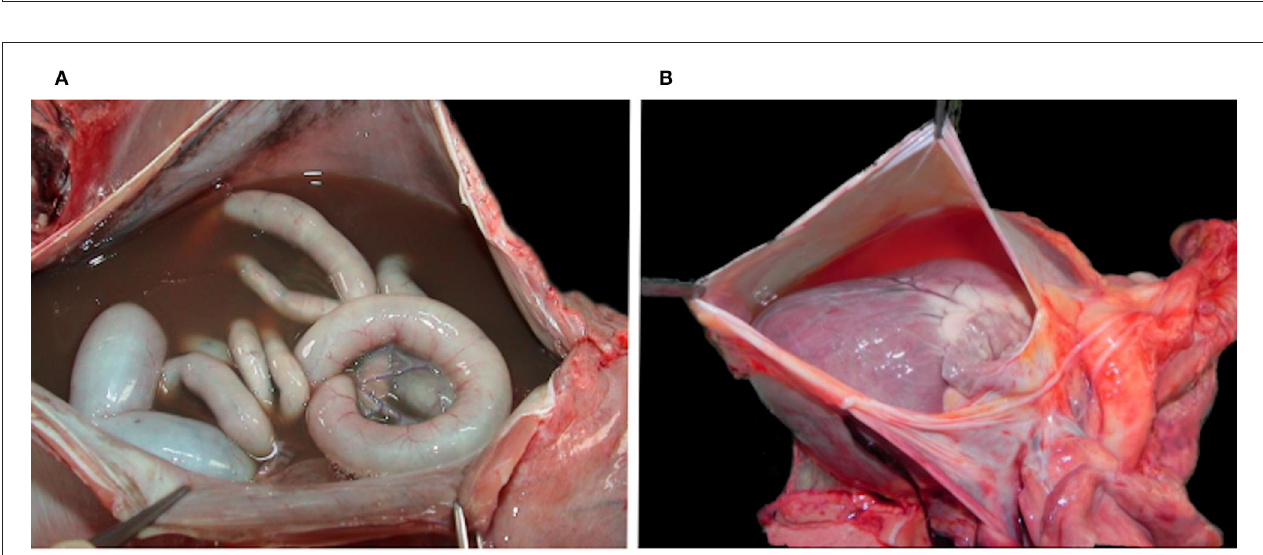
French/Swiss border. Case 1 and 2 and the control were ≤ 2 years old while the other four lynx were ≥ 7 years old. All were males except for case